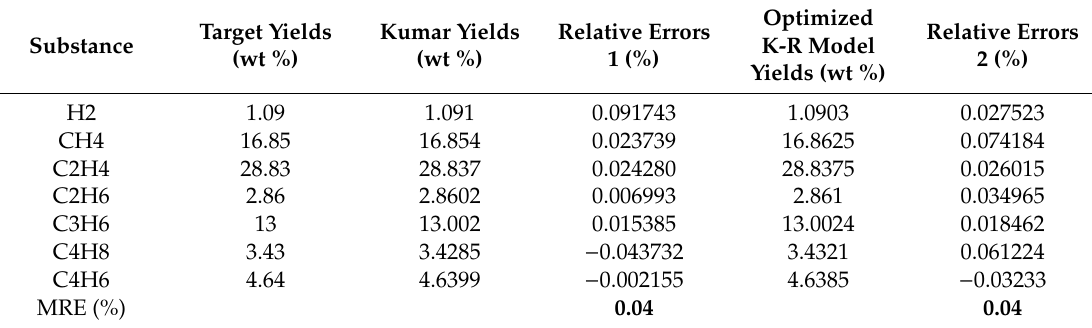
Table 11. The optimization result of naphtha (1).